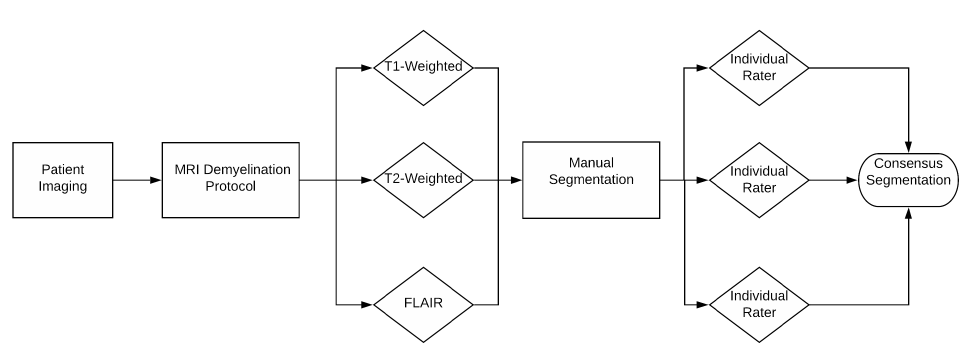
Figure 2. Manual segmentation pipeline from UMCL dataset